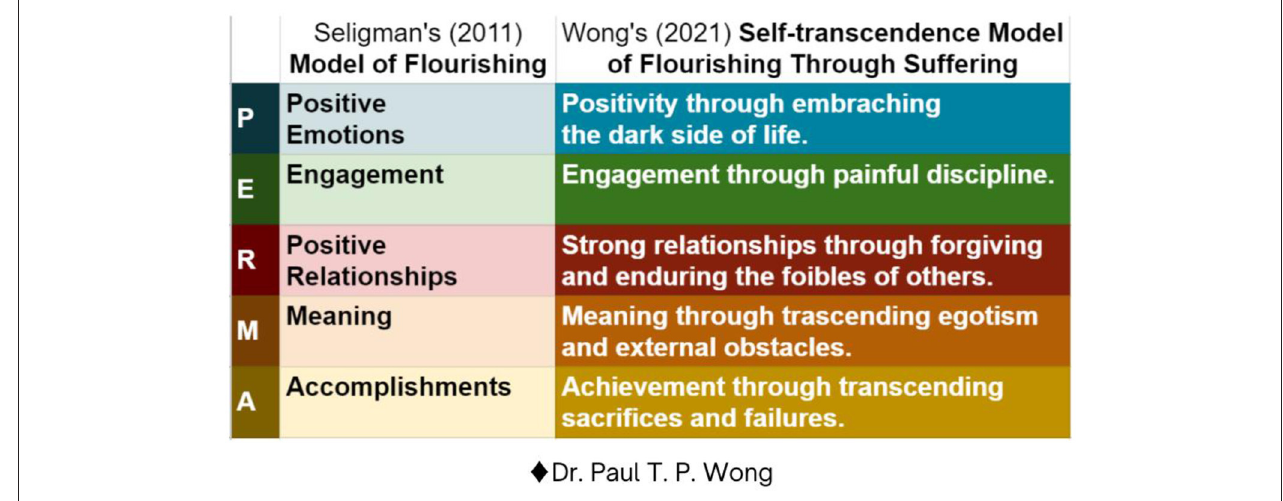
FIGURE 6 | Seligman’s (2011) model of flourishing compared with Wong’s (2021a) self-transcendence model of flourishing through